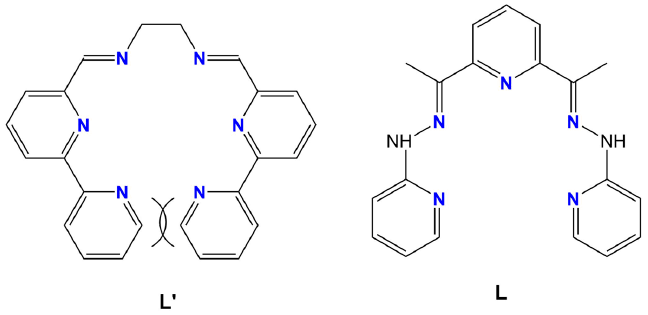
(cid:48) and N 5 ligand